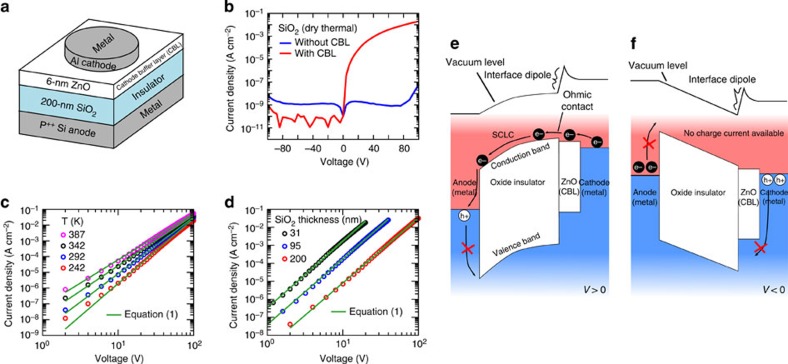
Characteristics and mechanisms of charge conductions in metal/insulator/cathode buffer layer/metal (MICM) structures.(a) Schematic structure of the MICM device consisting of P++-Si anode/insulator 200-nm SiO2/6-nm ZnO/Al cathode. (b–d) Current density-voltage characteristics of the MICM devices employing a thermally grown 200-nm SiO2 as the insulator; (b) with (red solid line) and without (blue solid line) the CBL; (c) under various temperature (T) conditions (symbols); (d) depending on the thickness of the SiO2 layer (symbols) at T=292 K. In c and d, green solid lines indicate theoretical fitting results to the measured curves using equation (1) with fitting parameters shown in Supplementary Table 1. (e,f) Schematic of current-rectifying mechanisms of the MICM device, when: (e) V>0, current flows by space-charge-limited currents (SCLCs) of electrons injected from the metal cathode; (f) V<0, charge injection processes are not allowed, and then there are no available space charge currents.